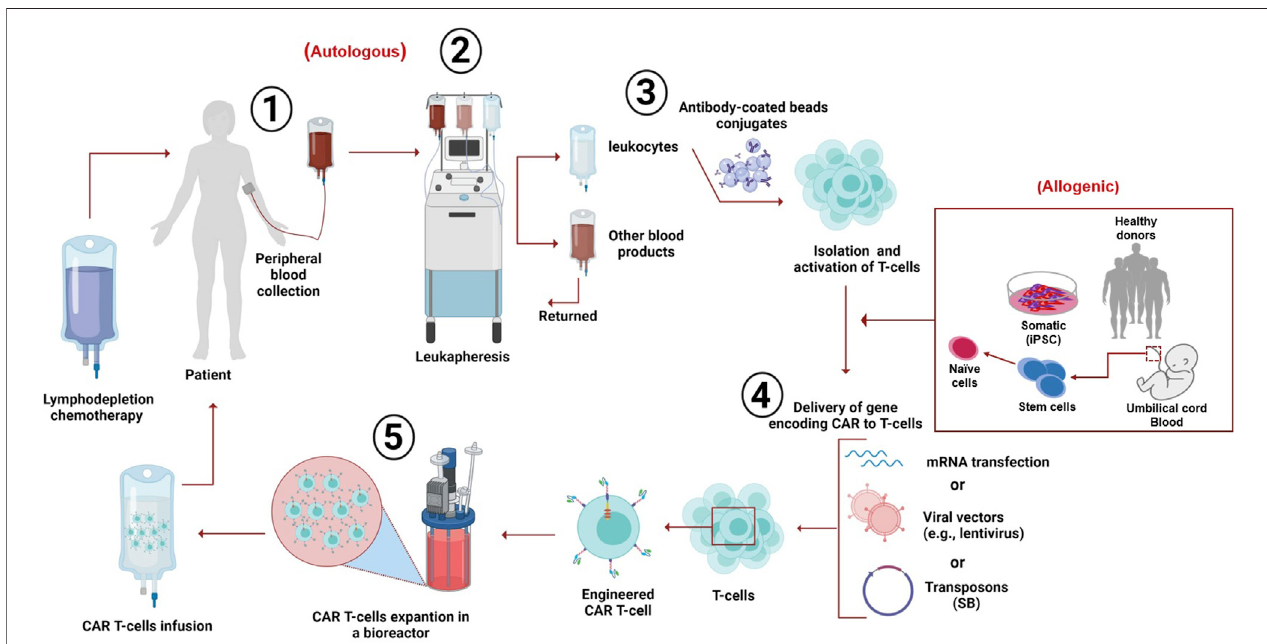
FIGURE 2 | Clinical production of CAR T-cells. The peripheral blood is withdrawn from the patient (autologous) or it can be obtained from the peripheral blood of a healthy donor (mononuclear cells), induced pluripotent stem cells (iPSC), or umbilical cord blood (allogeneic). The targeted T-cells are obtained by leukapheresis. Then, the T cells are separated and puri fi ed from other leukocytes using anti-CD3/CD28-coated beads; this process is followed by activation of the cells. Then, the genetic material encoding chimeric receptors is introduced into the T-cells via several known methods (such as mRNA transfection), viral vectors (e.g., lentivirus), or sleepingbeauty (SB) transposons.The engineered T-cells expressing CARs are thenexpanded inabioreactor. The patient receives chemotherapyfor decreasing white cells blood count; after 48 – 96 h, the CAR T-cells are reinfused into the patient, followed by close monitoring for a few days to observe any adverse effects.